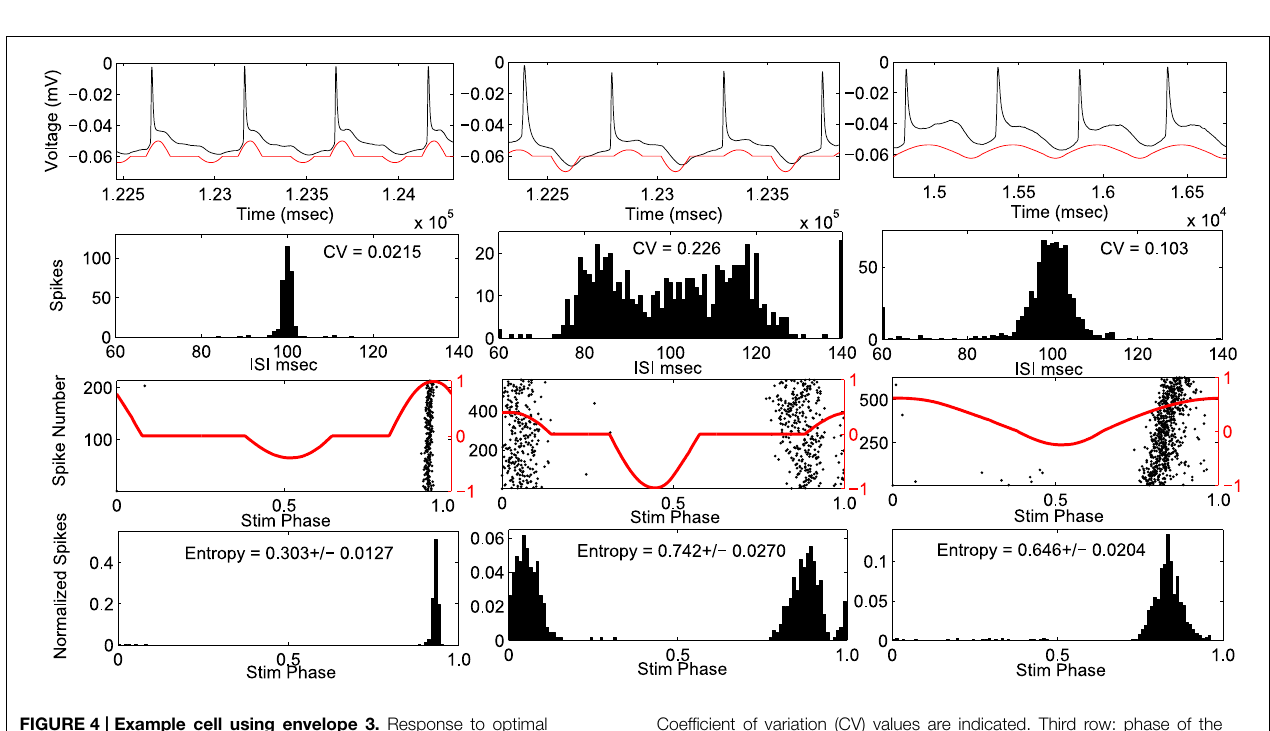
FIGURE 3 | Four envelopes with separate optimal waveforms were used to determine which stimuli to use on a given cell. The left panels show envelopes in gray with corresponding optimal stimulus waveforms